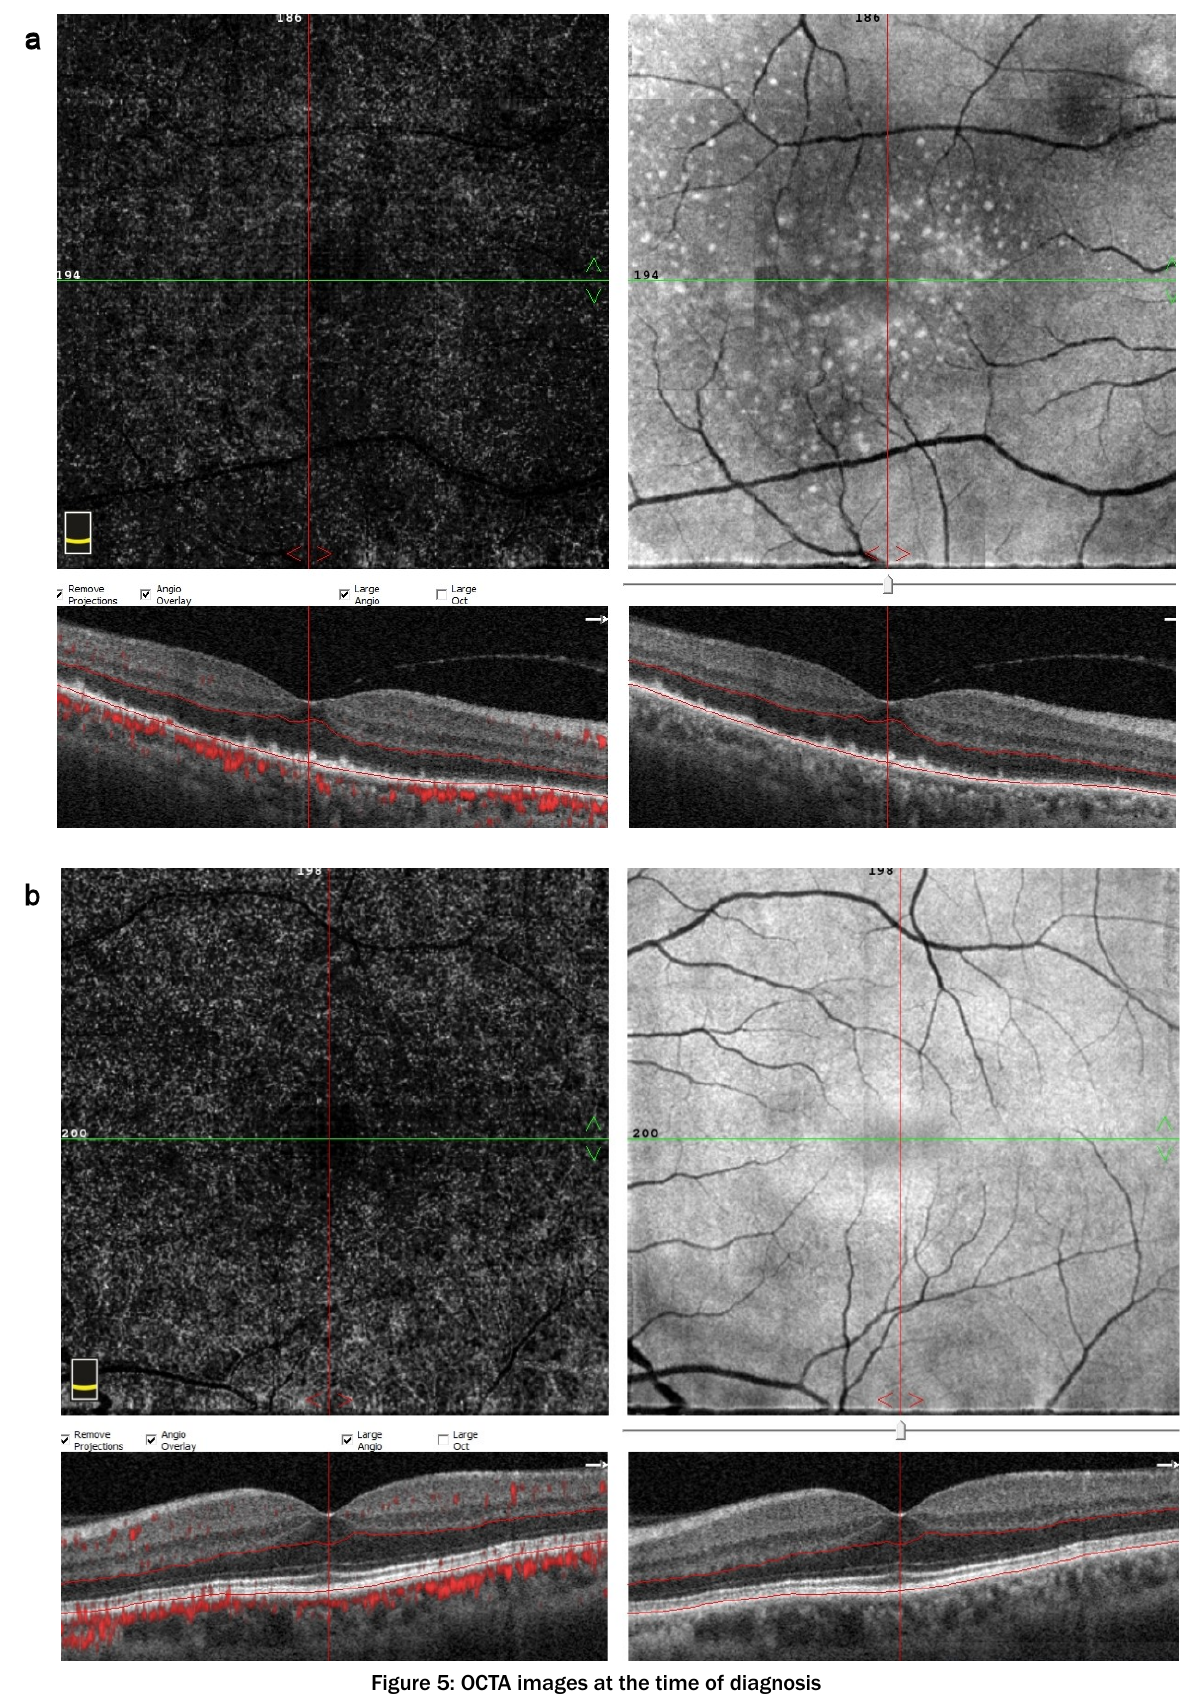
Figure 5: OCTA images at the time of diagnosis (a) Multiple hyperreflective dots in a starry-sky appearance on the en-face OCTA outer retinal slab of the right eye, (b) OCTA image of the left eye